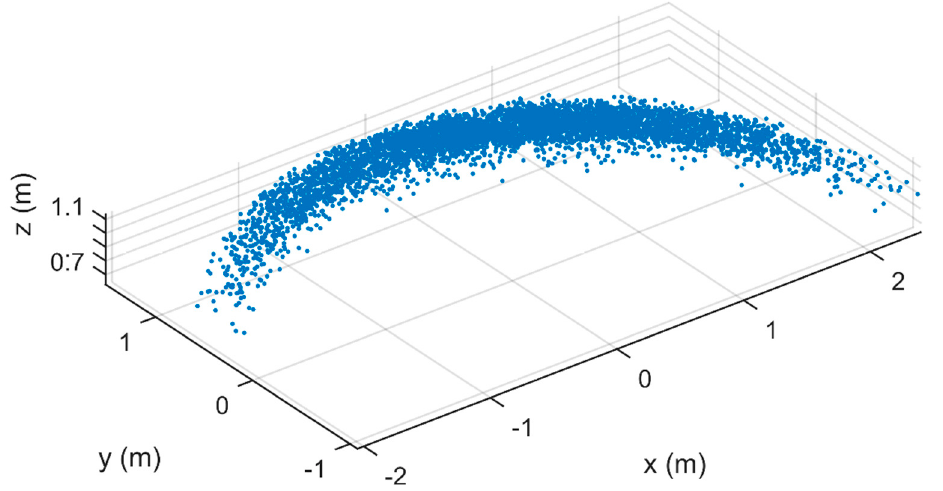
Figure 4. Particle 3D positions in spreader coordinate system. The spreader was set at configuration B.